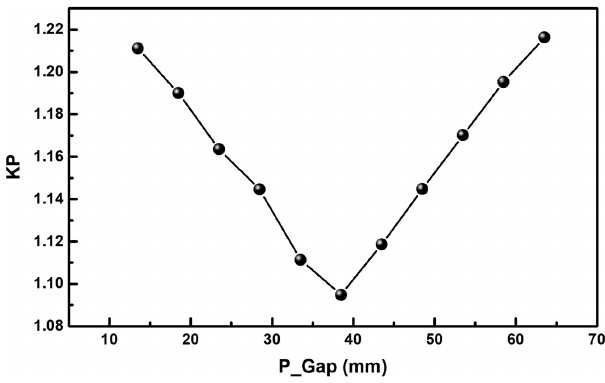
FIG. 19. Relationship between the peak surface electric field in the vane tips gap and the gap position (P_Gap) in a unit cell on peak br (cell length ¼ 76